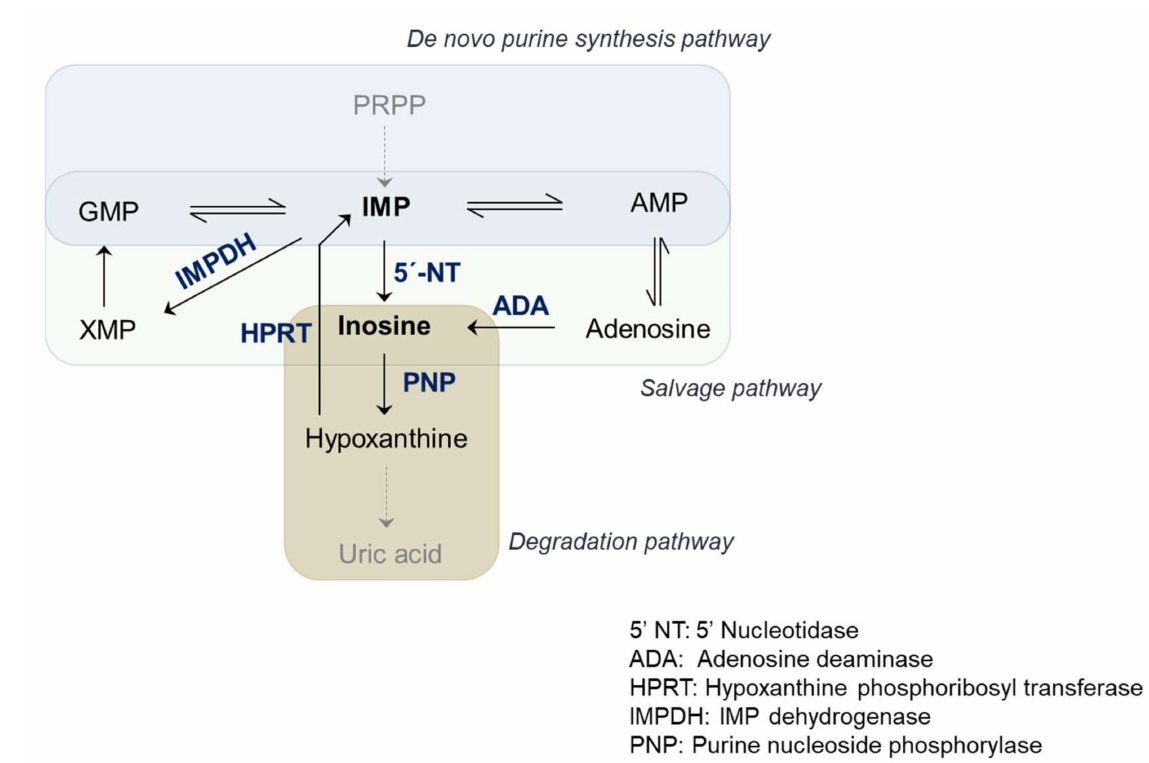
Figure 2. Purine metabolism. Inosine acts as a central intermediate in purine anabolic and catabolic